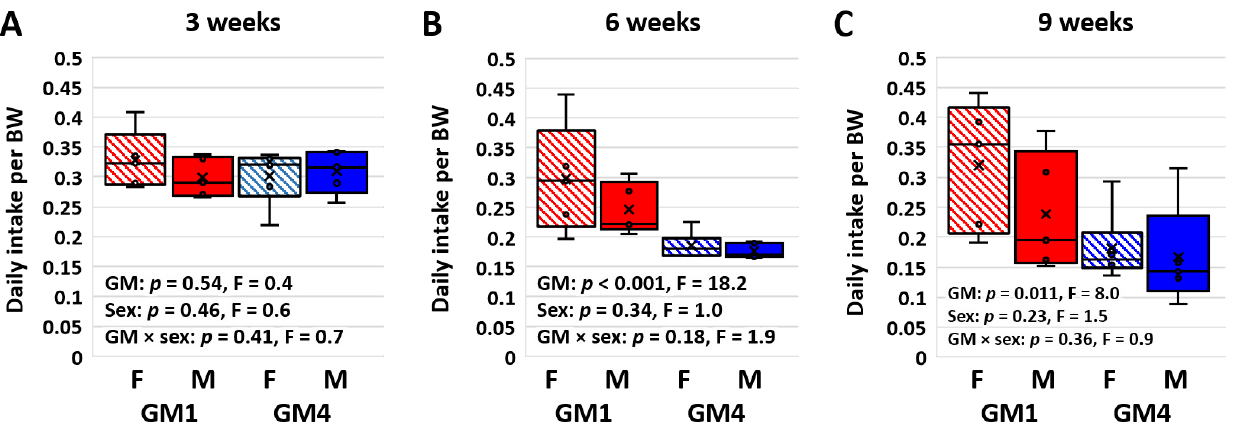
Figure 2. Box plots showing the body weight (BW)-adjusted daily intake in cages housing pairs of female (F) or male (M) mice colonized with GM1 or GM4 at three ( A ), six ( B ), and nine ( C ) weeks of age ( n = 5–6 cages/sex/GM). Statistical analysis was performed using two-way ANOVA within each time point.